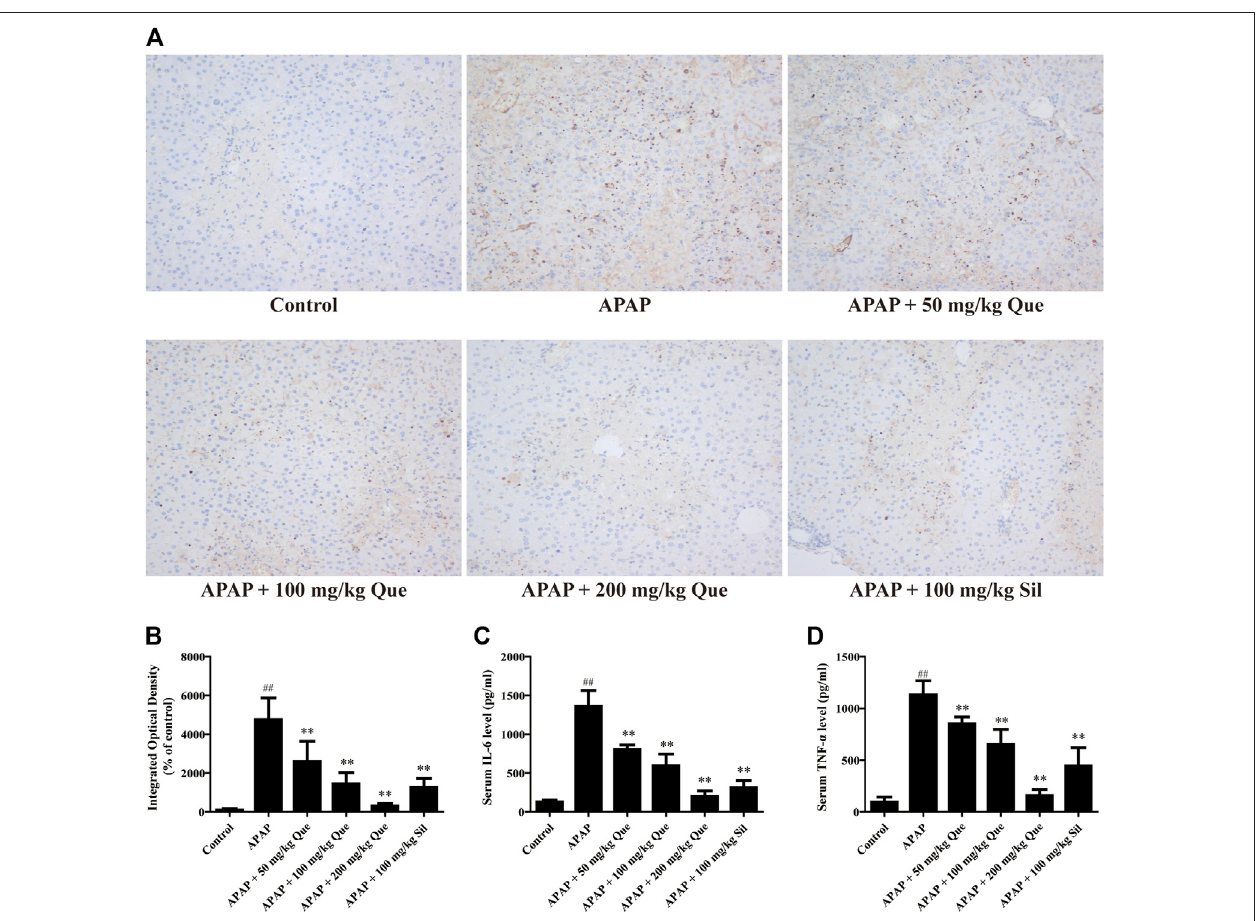
FIGURE 3 | Effect of quercitrin on APAP-induced in fl ammation. (A) Effect of quercitrin on F4/80 expression in the liver tissue of mice (200 × ). (B) IOD of immunohistochemistry. (C,D) Effect of quercitrin onserum IL-6 and TNF- α levels inAPAP-induced liver injury mice.The experimental data areexpressed asmean ± SD, ## p < 0.01, compared with the control group; ** p < 0.01, compared with the APAP